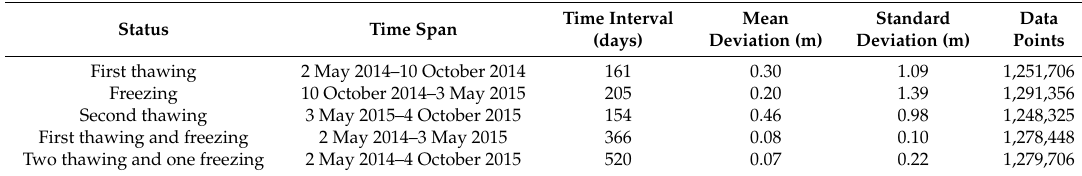
Table 2. Comparison of the topographical change statistics.